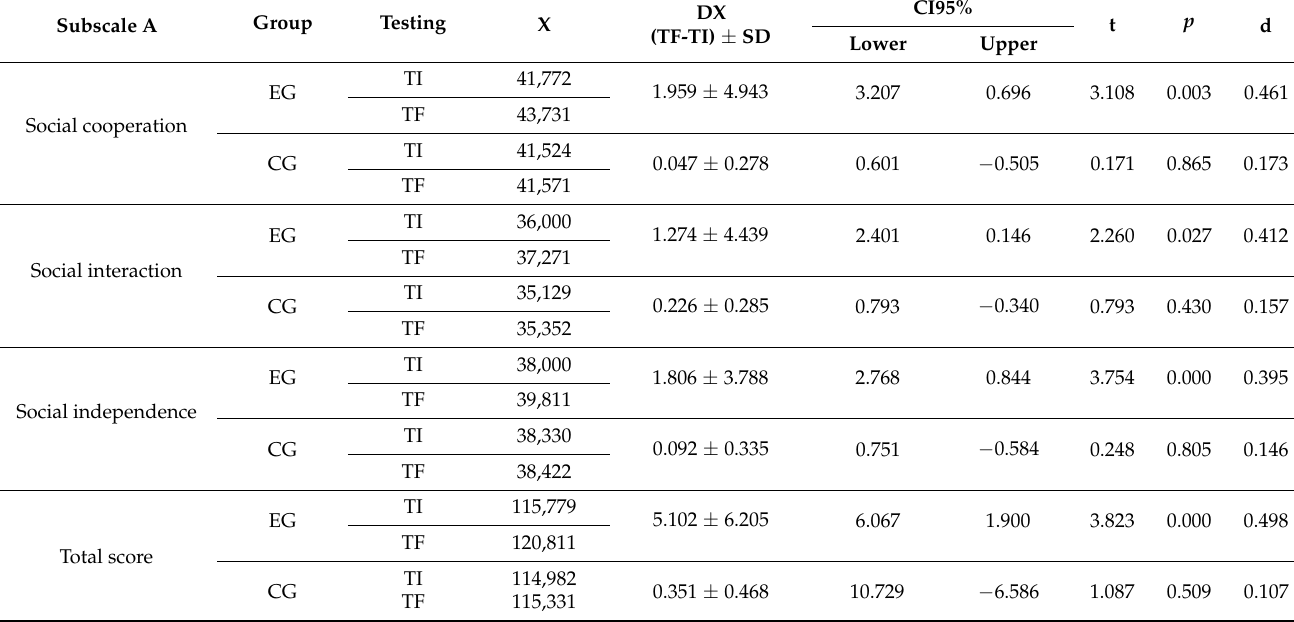
Table 4. The centralizer of results according to social skills—Scale A.